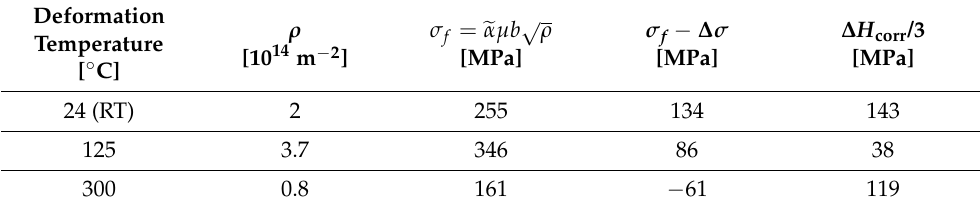
Table 6. Dislocation densities from TEM observations and Taylor stresses from the corresponding dislocation forests, as compared to the work hardening (Table 4) and hardness increase (corrected by